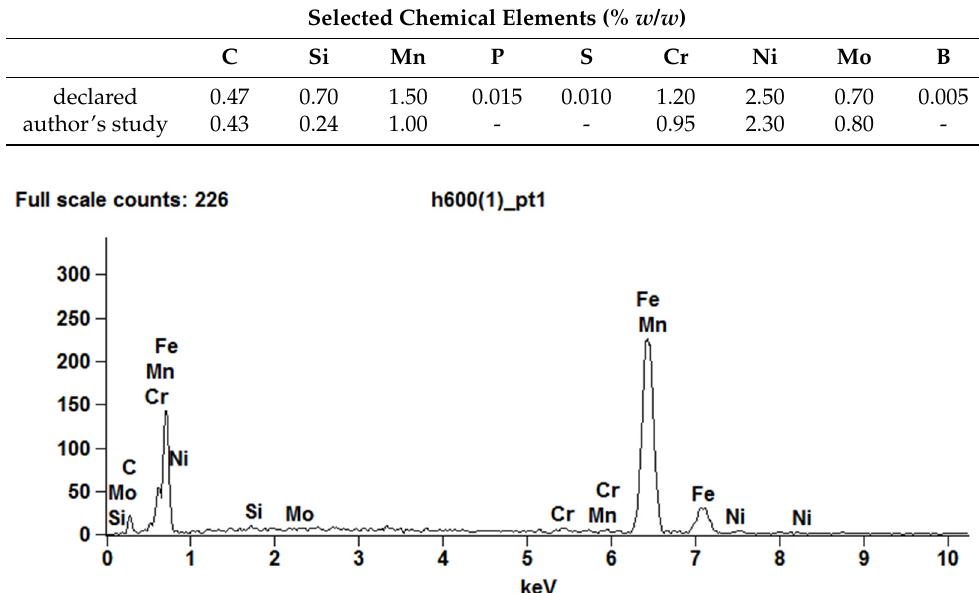
shows that they are carbides (V 4 C 3 ).